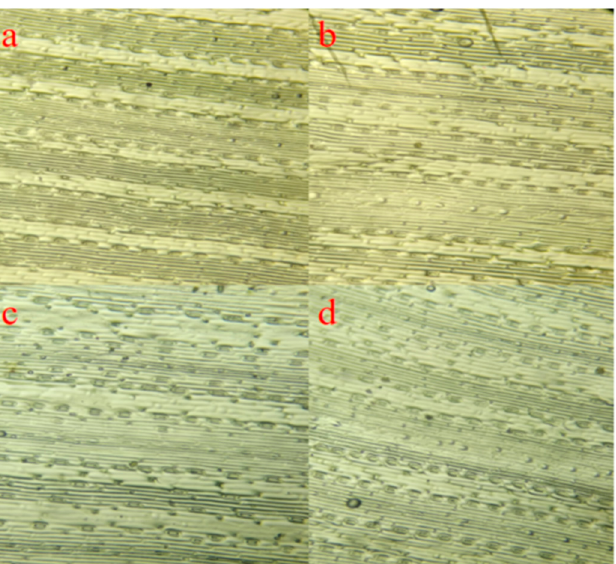
Figure 1. Stomatal morphology of winter wheat leaves at the anthesis stage. Subgraphs ( a – d ) show stomatal morphology of R-g, R-d, N-g, and N-d, respectively, treated under a microscope at 200 times magnification.